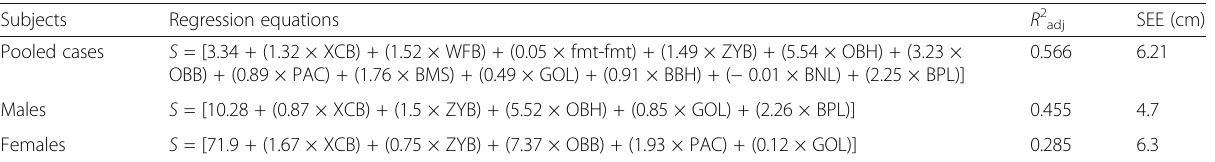
Table 8 multiple linear regression analysis to predict stature from skull measurements in pooled cases ( n = 150), males ( n = 80), and females ( n = 70) Regression equations R 2